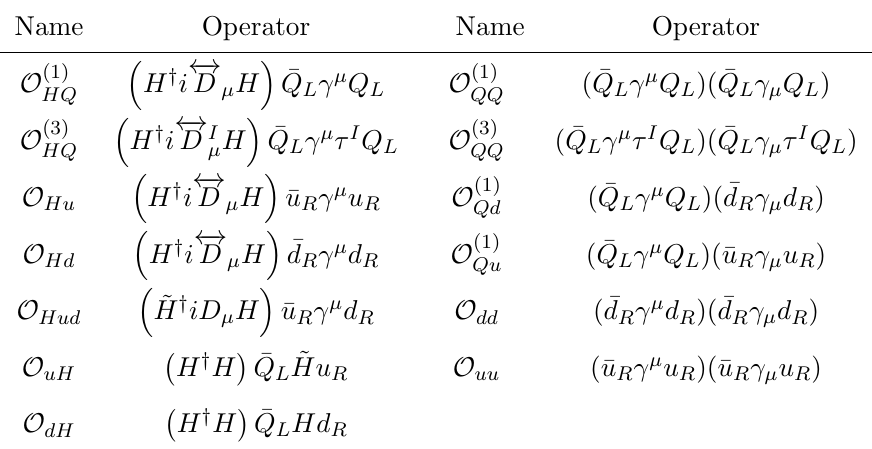
Table 1 . Dimension six SU(3) c from the clockwork gears. The notation for operators follows ref.